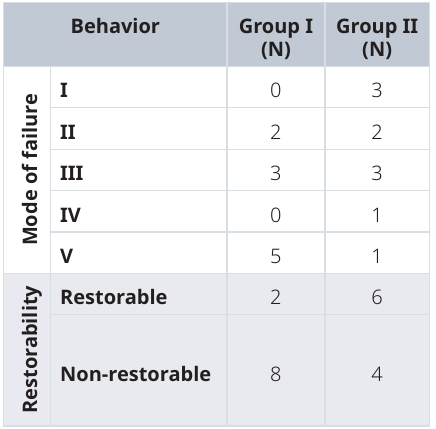
Equivalent (von-Mises) stress . The “von-Mises Stress” at different areas were calculated and compared (Table 7). The stress distribution values were generally found to be low.